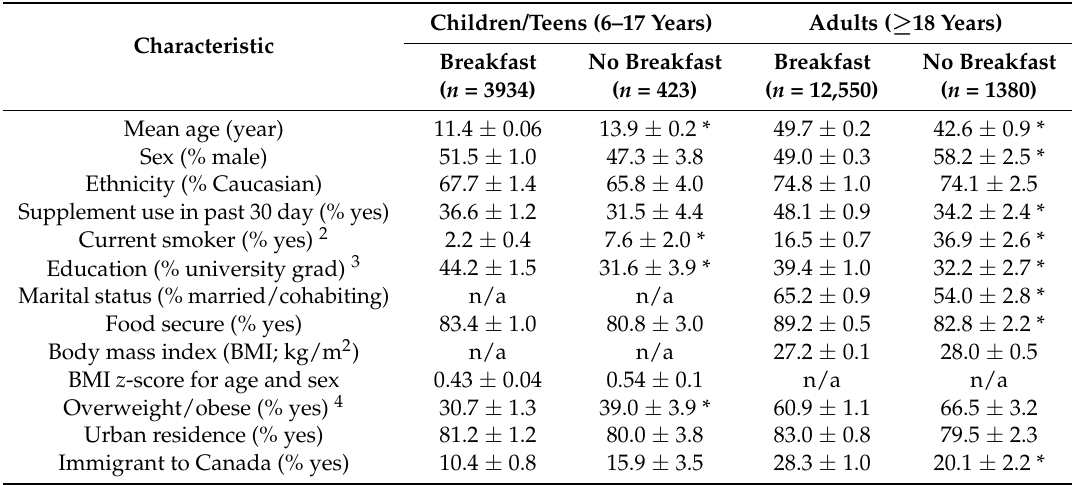
Table 1. Sociodemographic and lifestyle characteristics of Canadian breakfast consumers and non-consumers 1